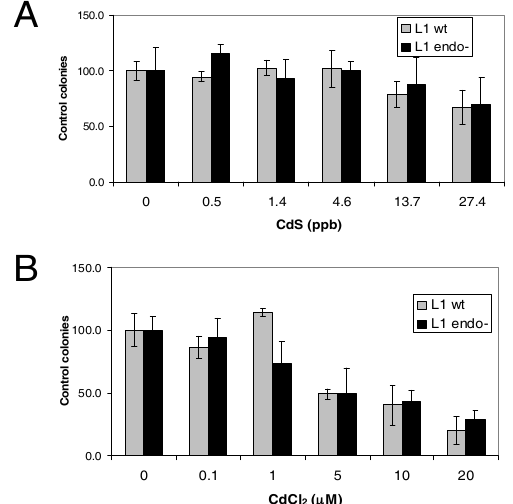
Figure 2: L1 endonuclease does not significantly contribute to the toxicity observed. HeLa cells were transfected with TAM102/L1.3, Figure 3: Comet assay evaluation of CdS treated cells.